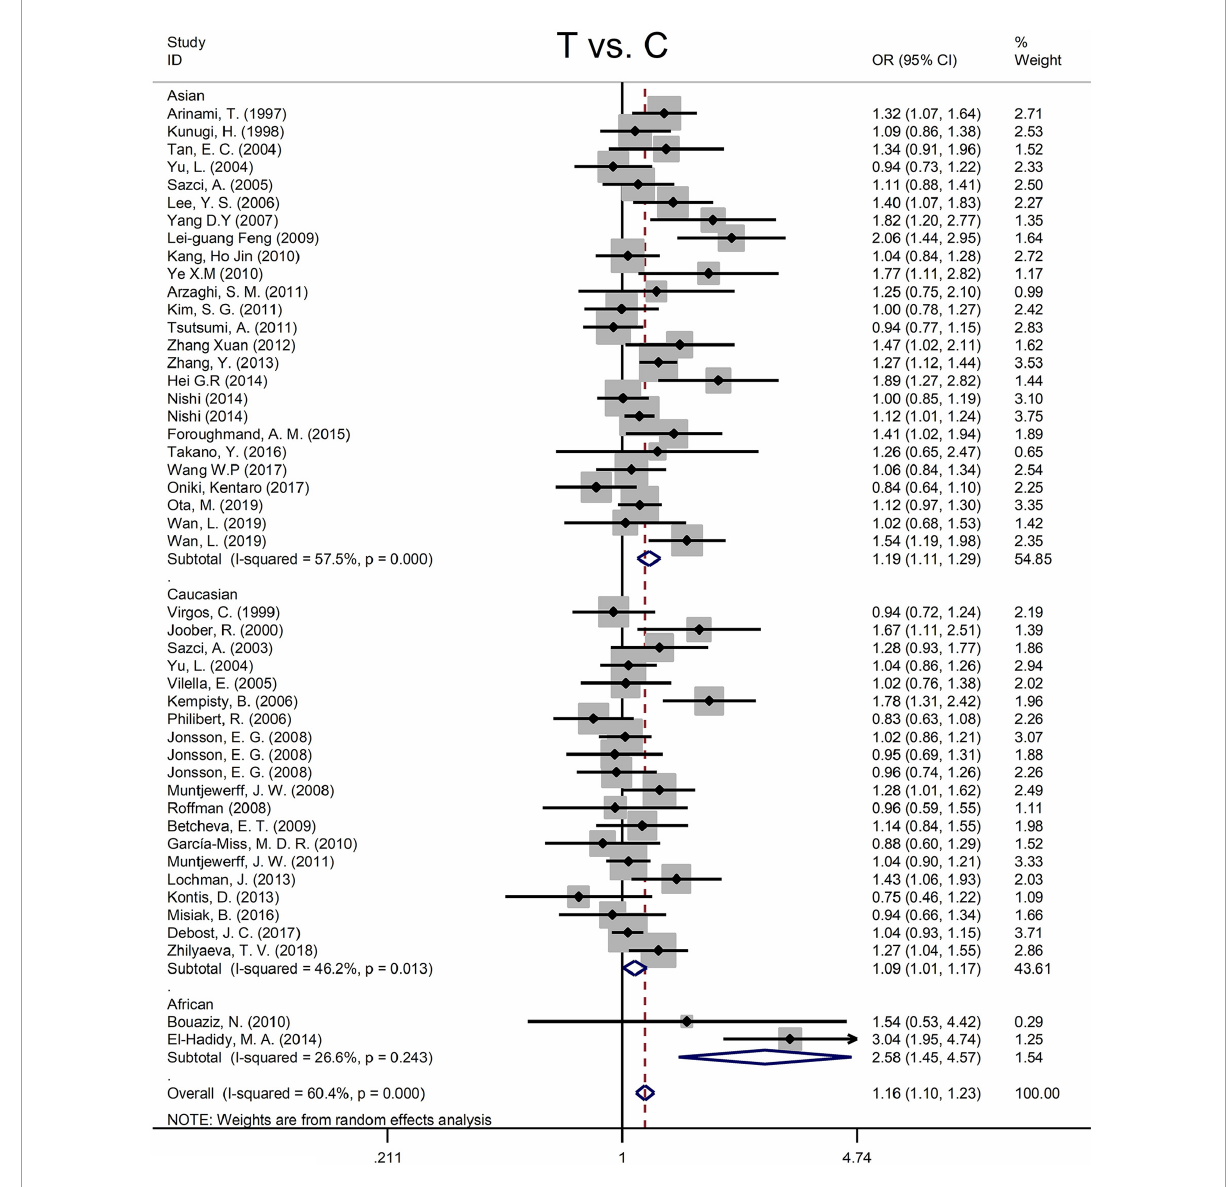
FIGURE2 Forest plots for the associations between MTHFR C677T polymorphisms and SZ for the allele model with random effect